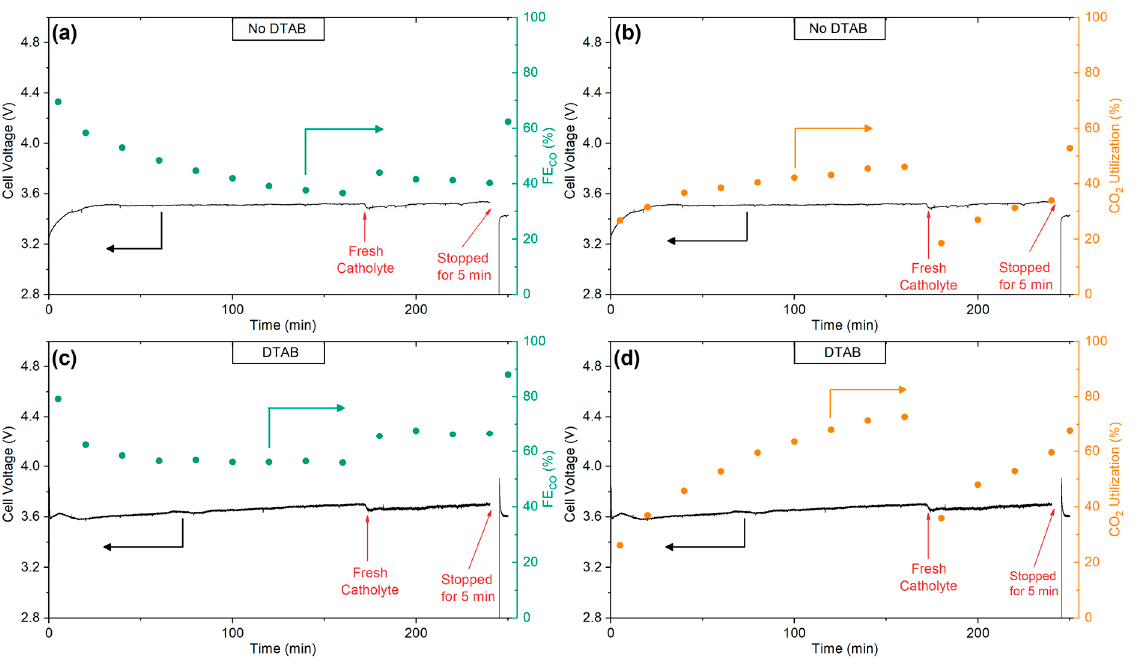
Figure 4. Cell potential, FE CO, and CO 2 utilization at 100 mA·cm − 2 of a system with ED1.5 as cathode, 50 °C and FBM bipolar membrane ( a , b ) without DTAB and ( c , d ) with DTAB added to the catholyte. At the beginning of the third hour, the catholyte was replaced by a fresh 2M KHCO